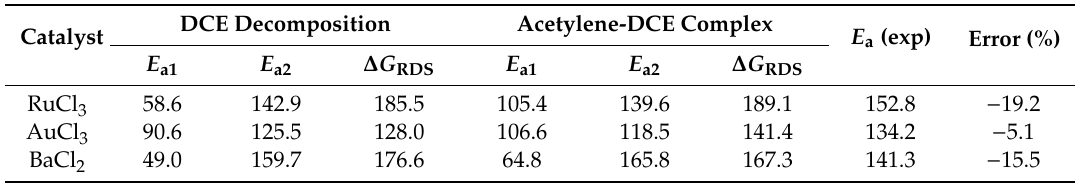
Table 2. Activation energies for two reaction pathways at 473.15 K. Experimental values and the relative errors are also listed. Energy unit: kJ mol − 1 .